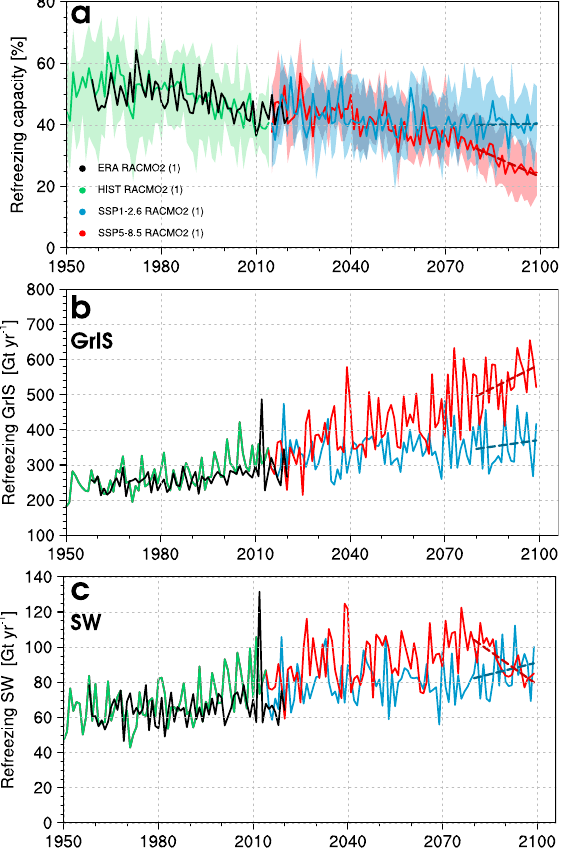
Fig.2|GrISrefreezingtrendsunderlowandhigh-endwarmingby2100.a Time series of GrIS refreezing capacity from CESM2-forced RACMO2.3p2 for the his- torical period (1950 – 2014), SSP1-2.6 and SSP5-8.5 (2015 – 2099) scenarios. The coloured bands in a span the minimum and maximum refreezing capacity of individual GrIS sectors. b and c Time series of refreezing spatially integrated over the GrIS and SW sector for the historical, SSP1-2.6 and SSP5-8.5 simulations. The